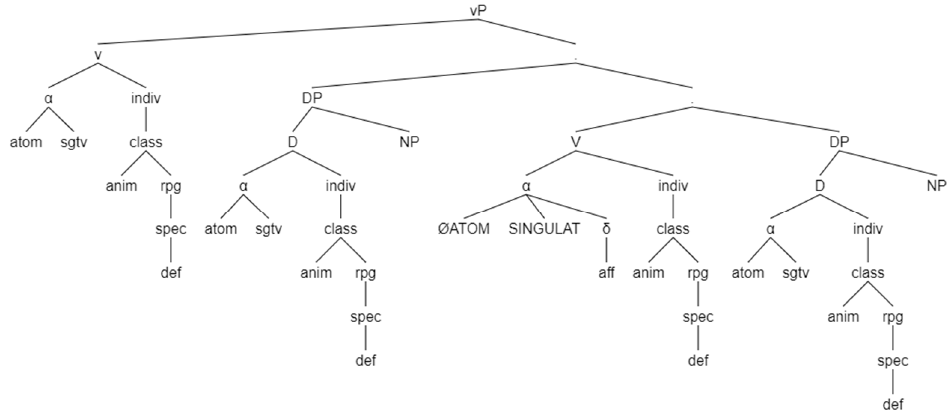
Figure 15. Geometry of the step 5.